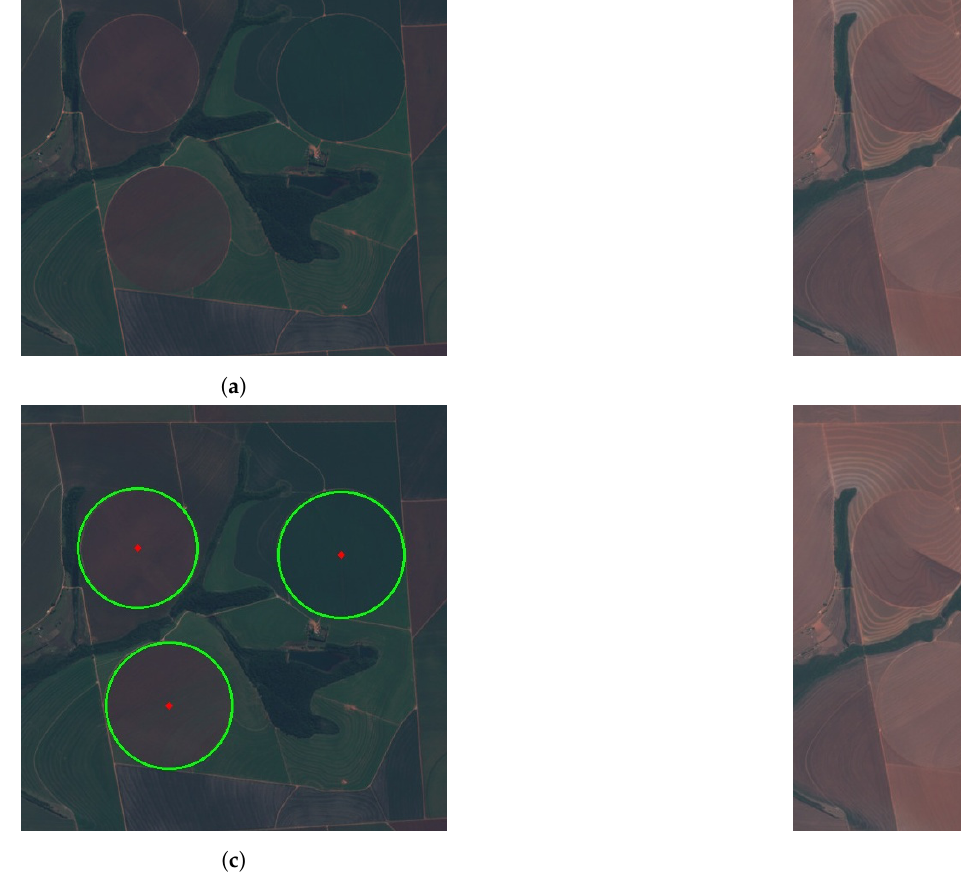
Figure 14. Center pivot irrigation systems at different times of the year. ( a ) Center pivot irrigation systems in June. ( b ) Center pivot irrigation systems in October. ( c ) Detection of center pivot irrigation systems in June. ( d ) Detection of center pivot irrigation systems in